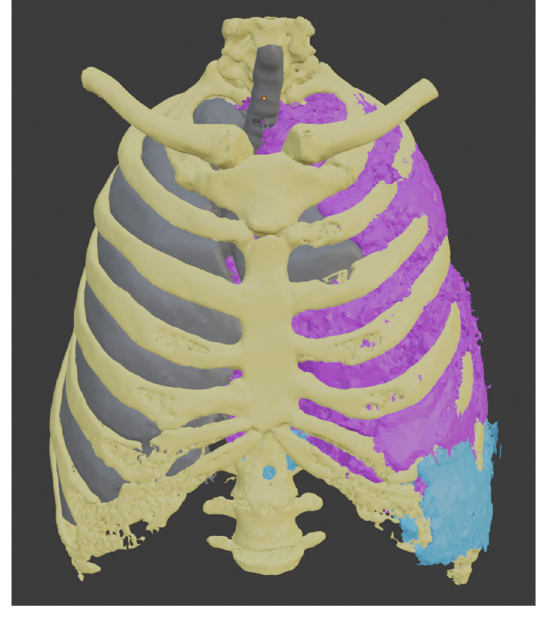
Figure 8. Models obtained by segmentation.